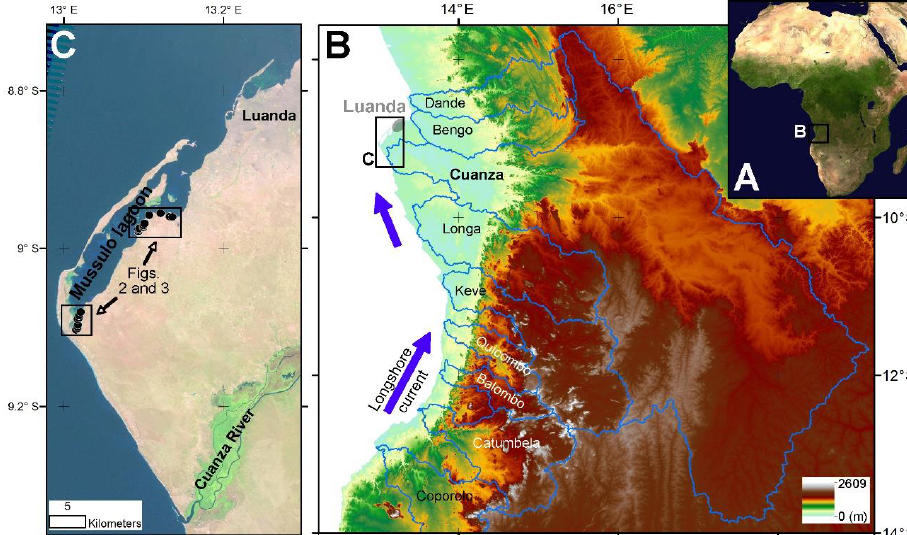
Figure 1. Geological setting of the lagoon of Mussulo. ( A ) The Angolan Atlantic margin in SW Africa and ( B ) orographic features of the regional drainage basins. Note that Cuanza is by far the biggest regional river. ( C ) The Mussulo spit and lagoon system extending until approximately the southern limit of Luanda urban area and location of the sampled sectors.